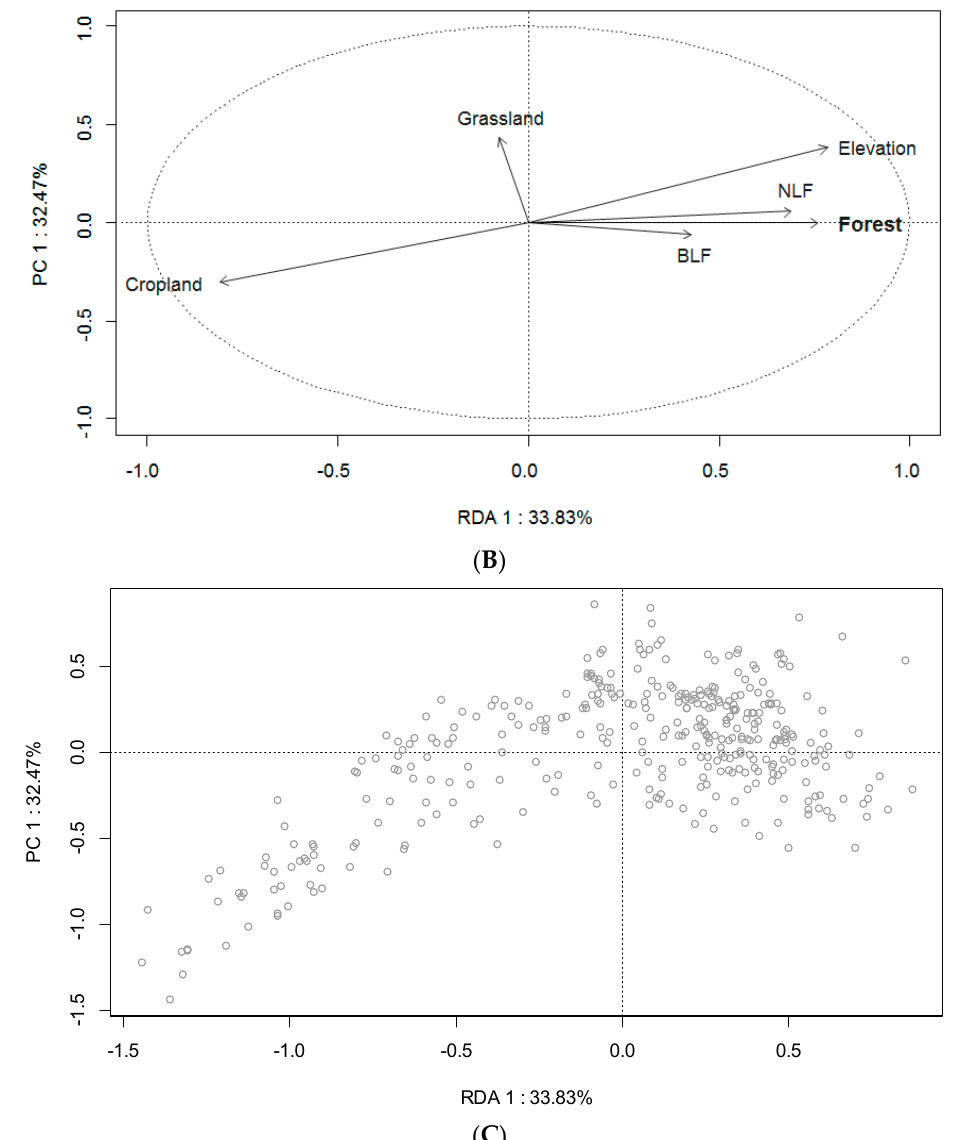
Figure 5. RDA results showing the link between forest cover and water quality. X-axis represents the constrained axis and y-axis, the first residual component. ( A ) Correlation circle of the RDA with “active” variables and the constrained variable (forest cover), with DO: Dissolved Oxygen, NO3: Nitrates, Cl: Chloride, SO4: Sulfates, TP: Total Phosphorus, NO2: Nitrites, NH4: Ammonium and DOC: Dissolved Organic Carbon. ( B ) Correlation circle of the RDA with constrained variable (forest cover) and “passive” variables (with NLF: Needle-leaved forest and BLF: Broad-leaved forest). ( C ) Stations location in the same plan.